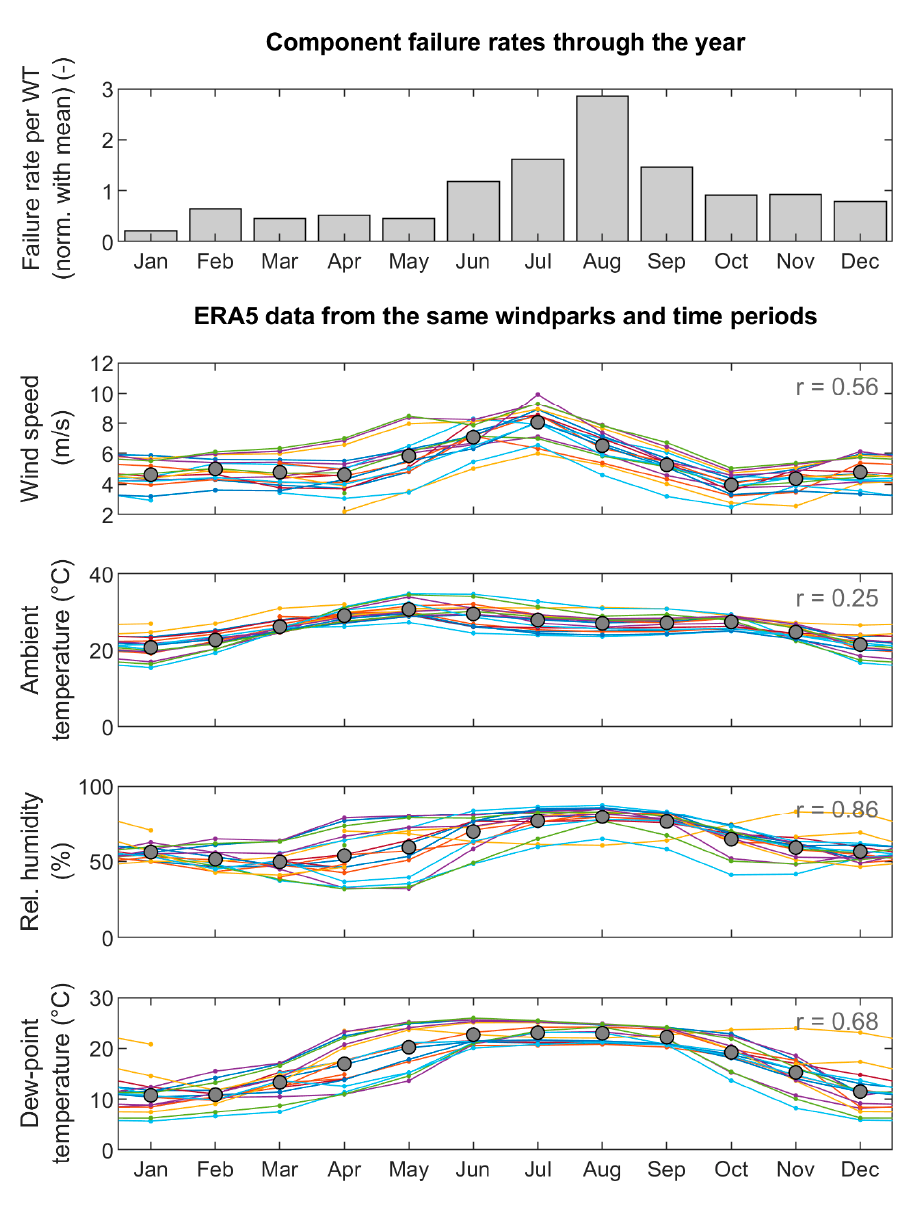
Figure 3. Seasonal variation of phase-module failure rates in a WT fleet with liquid-cooled converters in India (based on field failure data from 590 WT operating years, cf. [4,6]) with corresponding monthly average wind-speed and environmental conditions (each line represents one wind farm, grey markers indicate the average across the wind farms, r values describe the correlation with the failure rates).